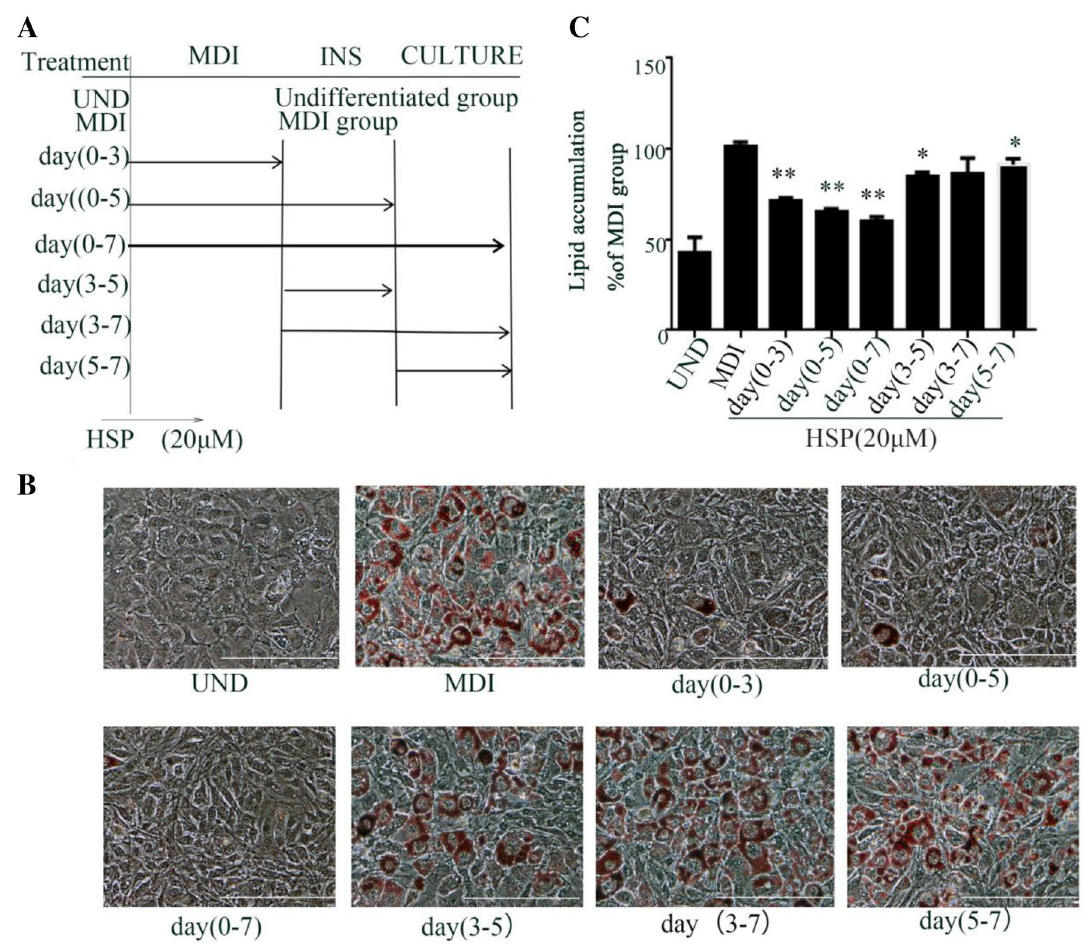
Fig. 4 Hypersampsone P blunted adipocyte differentiation at the early-stage. a Workflow of cells treated hypersampsone P during the different periods of adipocyte differentiation. b Representative images of 3T3-L1 adipocytes treated by hypersampsone P at the different